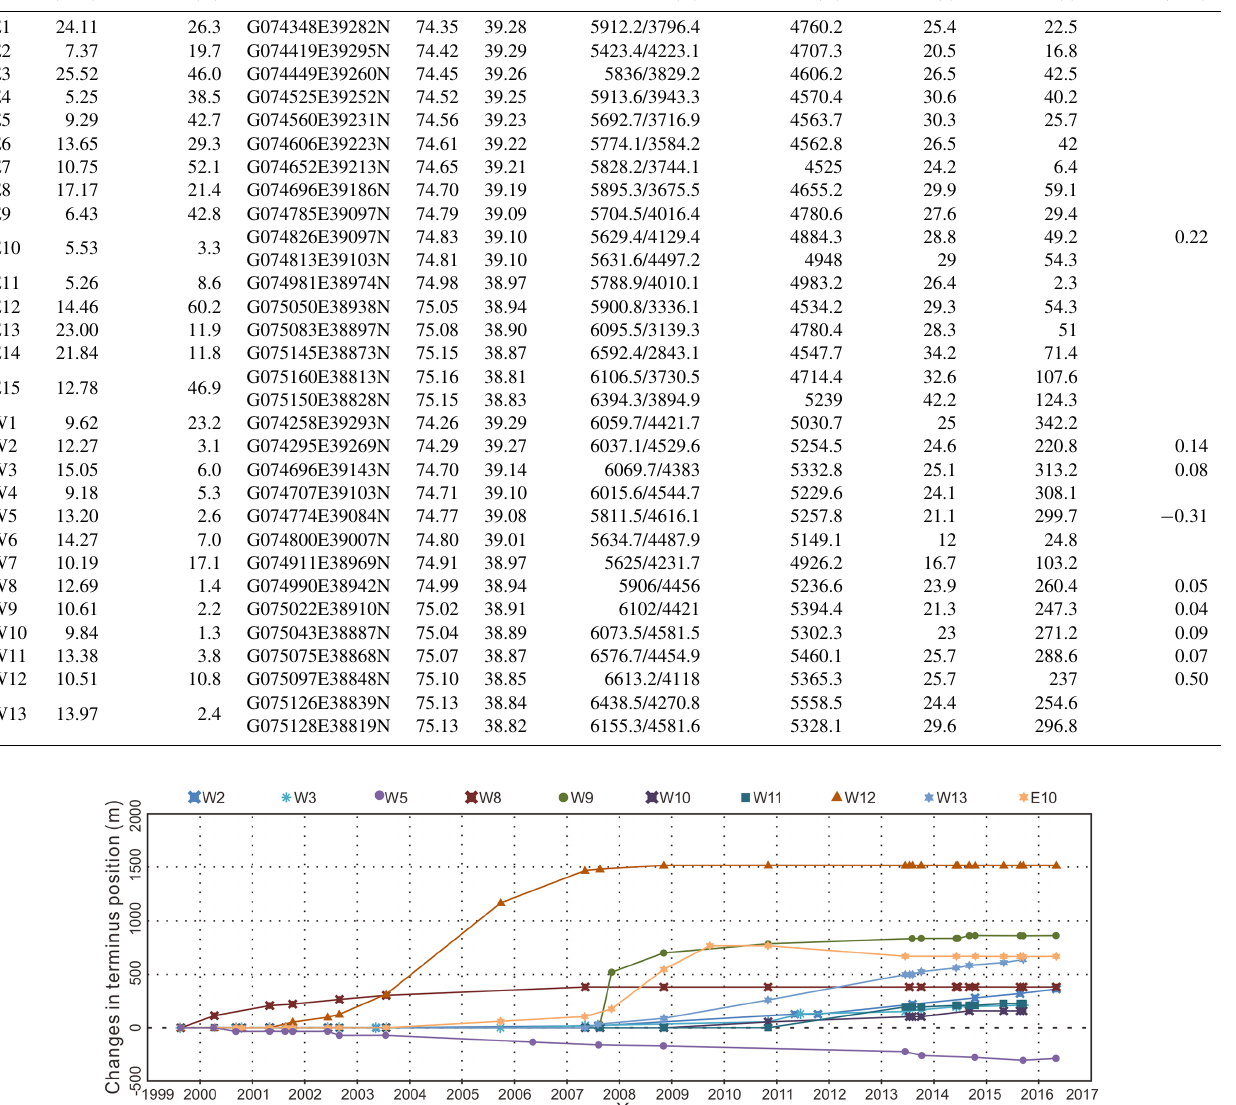
Figure 3. Changes in glacier terminus positions from 1999 to 2016 for 10 glaciers with detectable